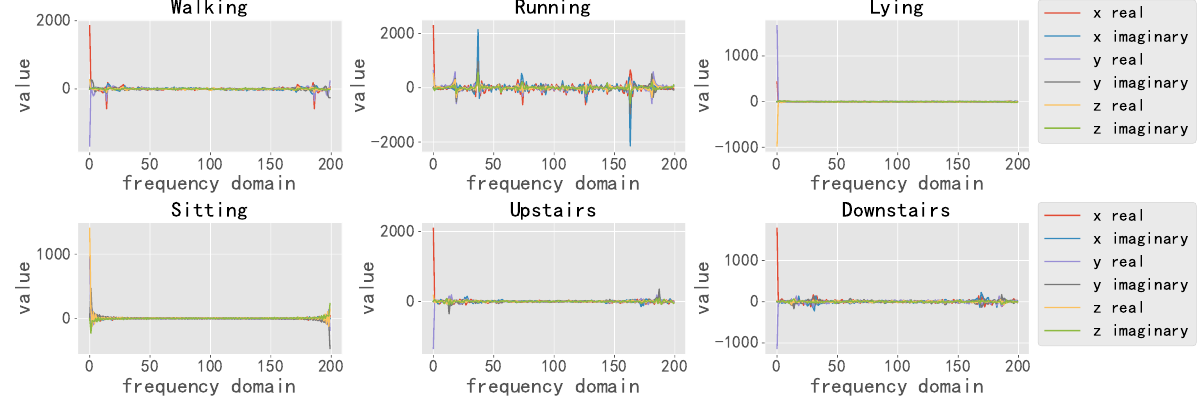
Figure 3. Accelerometer data after Fourier